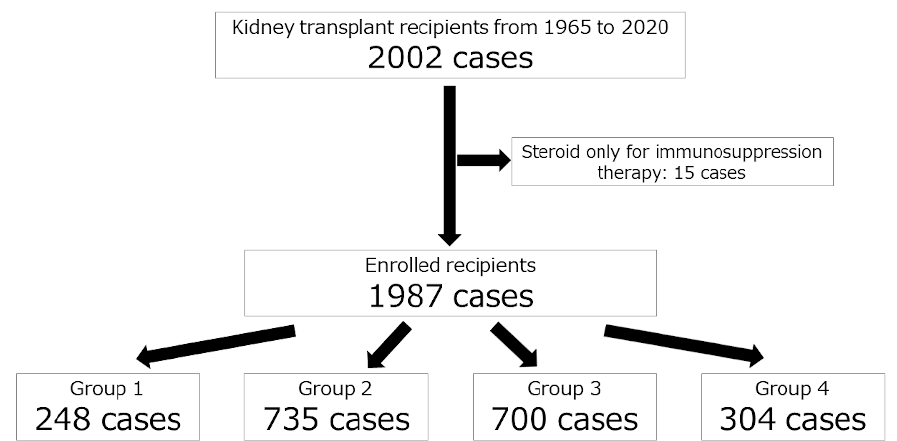
Figure 1. A diagram describing the study population. Table 1. Demographic characteristics of transplant recipients.